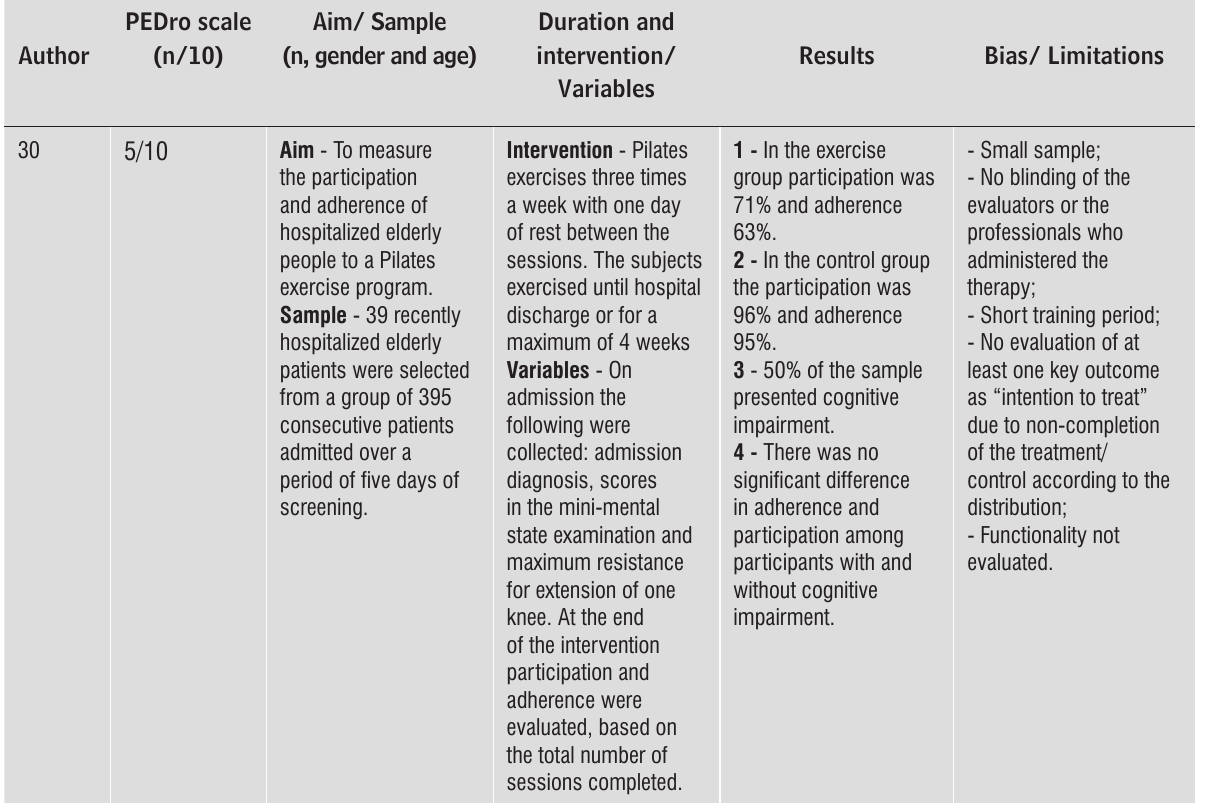
Table 2f - Field studies (continuation)